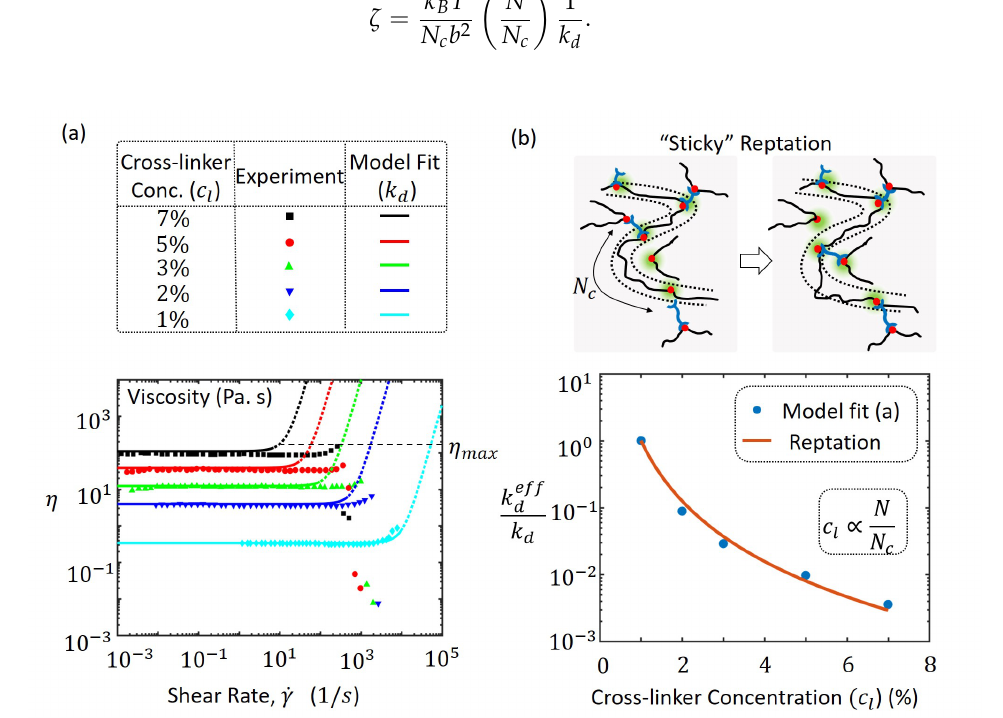
Figure 5. ( a ) experiment and model prediction of poly(4-vinylpyridine) (PVP) cross-linked with bis-Pd(II) complex for different cocncentration of cross-linkers [29]. The dotted lines for the model prediction indicate viscosity beyond the failure point with maximum viscosity η max ; ( b ) illustration of the “sticky” reptation mechanism at large concentrations with constrained chain movement in a tube with intermittent cross-linkers. Shown below is the plot of effective dissociation rates, k ef f from fitting the experimentally measured viscosities of ( a ) and prediction of the reptation